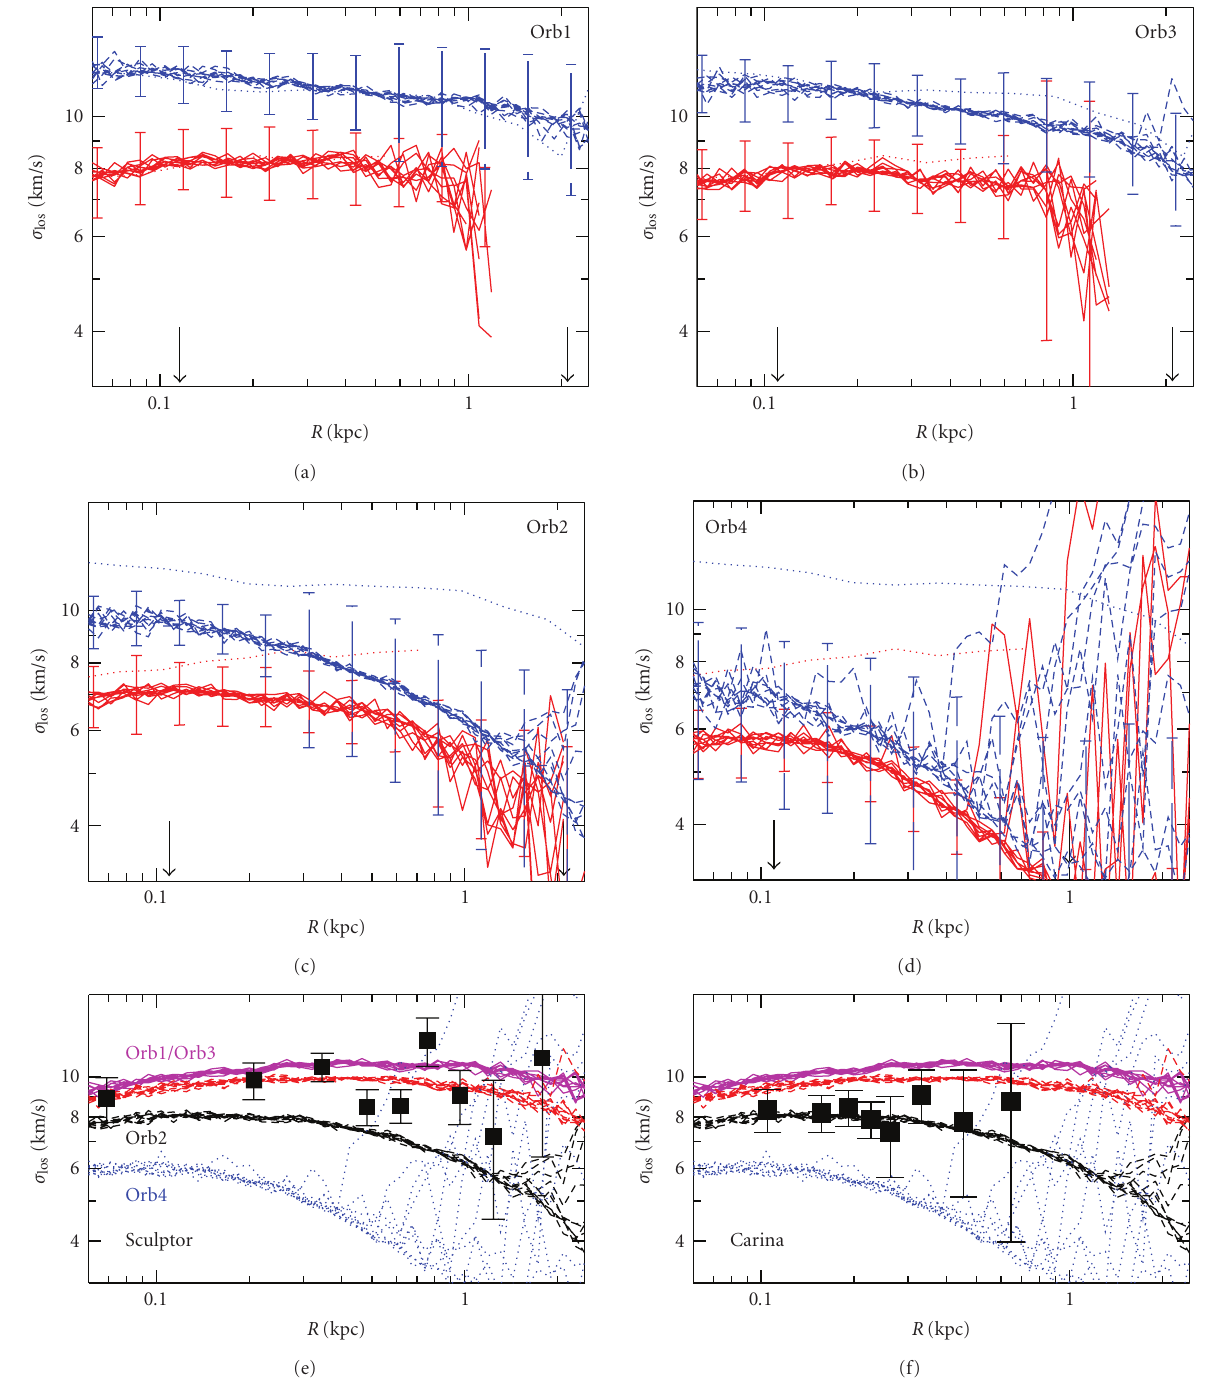
Figure 5: (a)–(d) Line-of-sight velocity dispersions for both luminous components as a function of the (projected) distance from the center of the satellite. Solid red and dashed blue curves correspond to the concentrated ( C 1 ) and the more extended ( C 2 ) components, respectively. The error bars indicate the rms dispersion on the σ los profiles of 100 random samples containing 500 particles each (see text for details). For reference, the dotted lines show the initial configuration of the model satellite. Black arrows indicate the positions of the core and tidal radii in each experiment. (e), (f) Velocity dispersion profiles for Sculptor and Carina dwarfs (squares with error bars). Data was taken from Battaglia et al., koch et al., and Helmi et al. [11, 36, 37]. The total (no distinction between components) σ los profiles for our models in the 10 di ff erent projections are also shown in magenta, black, red and blue lines for Orb1–Orb4,